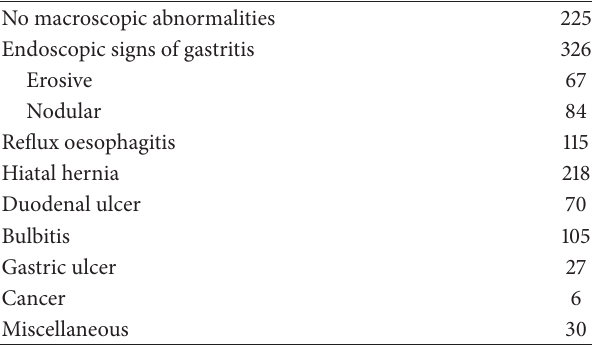
Table 1: Endoscopic diagnoses in 779 patients with positive culture for H . pylori with known endoscopic diagnosis.